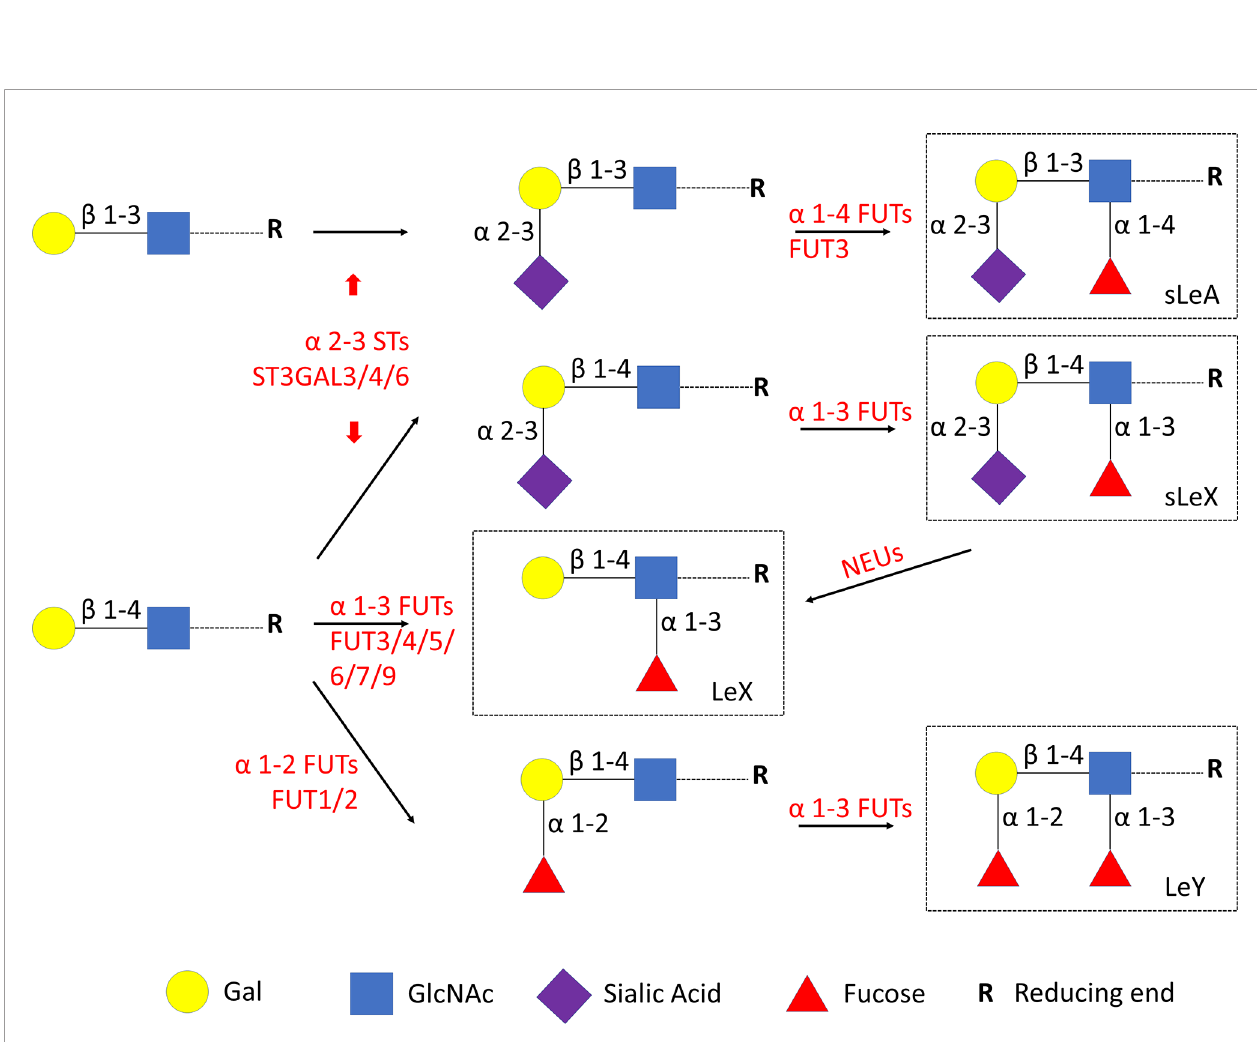
FIGURE 3 | Lewis antigens biosynthesis. FUTs, fucosyltransferases. STs, sialyltransferases. NEUs, neuraminidases. Gal, galactose. GlcNAc,